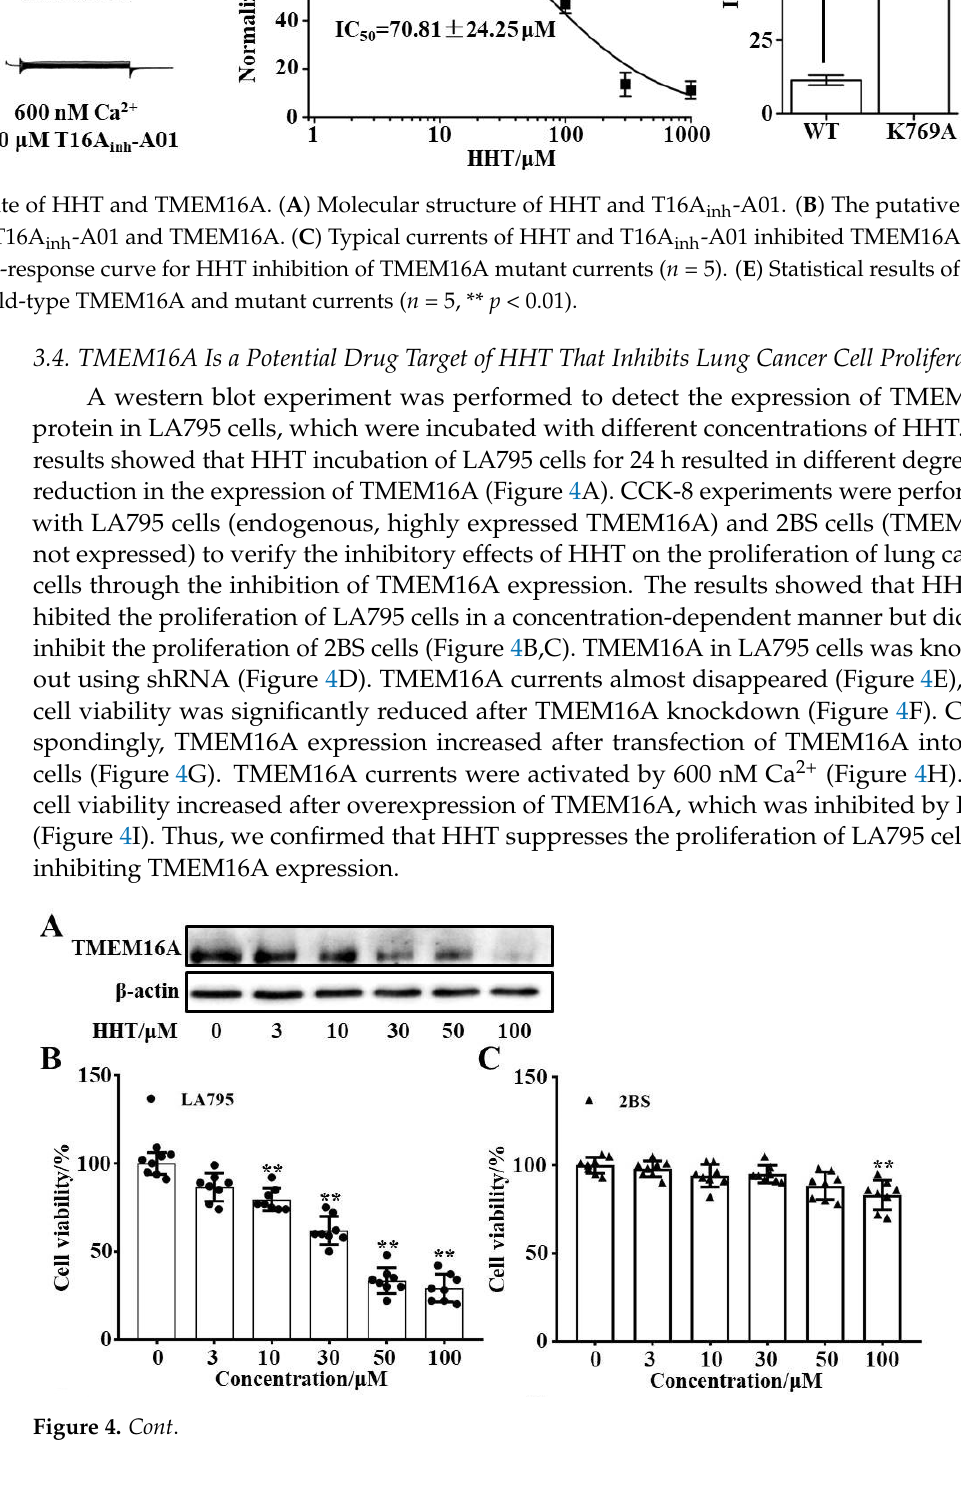
Figure 4. HHT inhibited lung cancer cell proliferation through inhibited TMEM16A. ( A ) TMEM16A protein expression treated with different concentrations of HHT for 24 h. ( B , C ) Inhibi- tory effect of HHT to the proliferation of LA795 and 2BS cells with different concentrations ( n = 8). ( D ) Expression of TMEM16A protein in LA795 cells before and after shRNA transfection ( n = 3, ** P ＜ 0.01). ( E ) Typical whole-cell currents of TMEM16A in LA795 cells before and after shRNA transfection ( n = 5). ( F ) Cell viability of LA795 cells before and after shRNA transfection ( n = 8, ** P ＜ 0.01). ( G ) Expression of TMEM16A protein in 2BS cells before and after TMEM16A transfection ( n = 3). ( H ) Typical whole- cell currents of TMEM16A in 2BS cells before and after TMEM16A transfection ( n = 5). ( I ) Cell viability of 2BS cells before and after TMEM16A transfection ( n = 8, ** P ＜ 0.01).